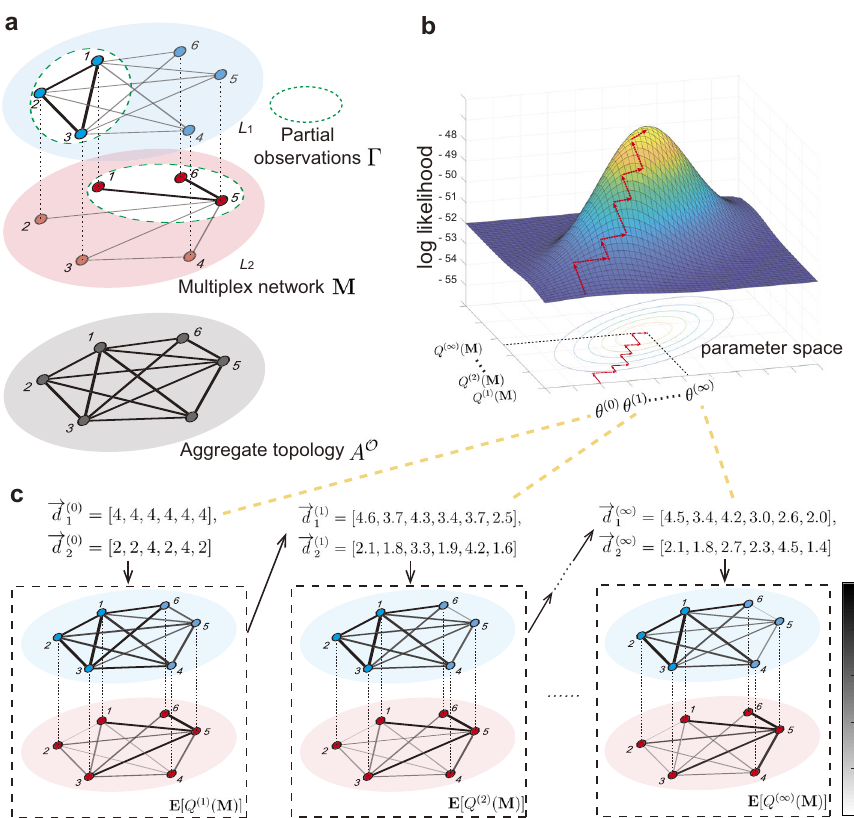
Fig. 2 A schematic illustration of the reconstruction method for multiplex networks. a A multiplex networks M is composed by L 1 and L 2 (the two layers of the multiplex network), and the bold edges in dashed white area indicate the partial observations Γ . A O is the monoplex topology aggregated by the multiplex network M. The aggregate topology A O and partial observations Γ are leveraged to reconstruct the links in different layers that have not been observed directly. b The locus of the coordinate ascent method is shown in the probability space, where the red arrows show the repetitive process updating the parameter θ and structure distribution Q (M) maximizes the likelihood. c A toy example is provided to demonstrate the speci fi c iterative steps, where the parameter θ indicates the degree sequences d structure distribution E [ Q (1) (M)], where the gray level and the thickness of each link indicates the existent probability estimated by the proposed method. When repeating this process, we can obtain the convergent degree sequences d